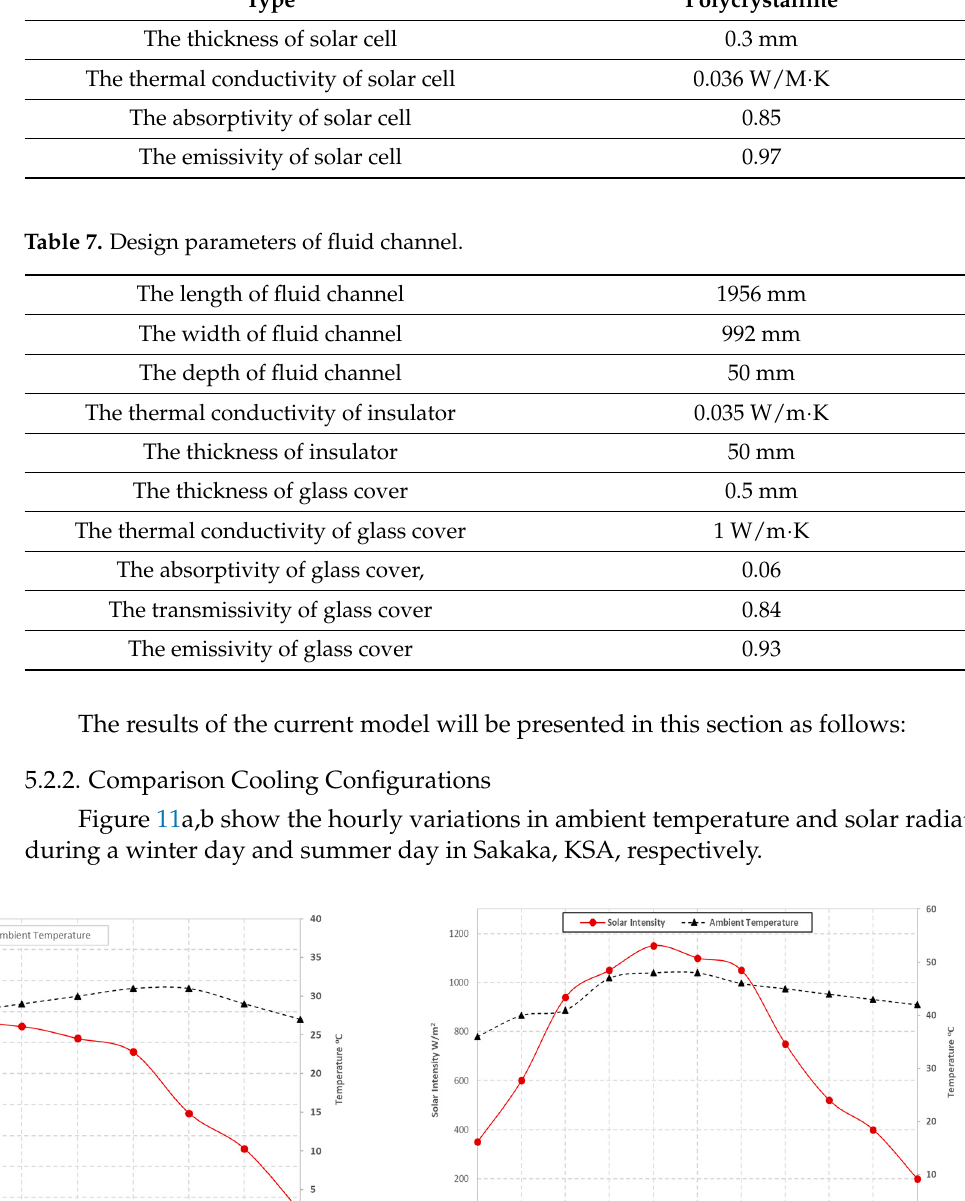
Table 6. PV panel characteristics.